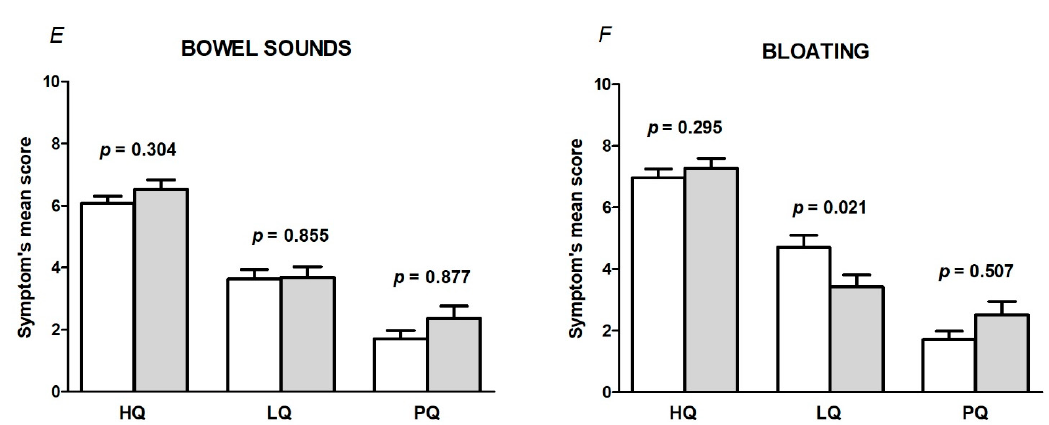
Figure 2. Global symptom score (GSS) ( A ) and diarrhea ( B ), abdominal pain ( C ), vomiting ( D ), bowel sounds ( E ), and bloating ( F ) mean scores in the studied population, subdivided according to lactose hydrogen breath test results. Lactose malabsorbers (HBT positive after lactose challenge), lactose absorbers (HBT negative after lactose challenge), respectively. HQ: home questionnaire; LQ: lactose questionnaire; PQ: placebo questionnaire. (6) The distribution of GSS at LQ, according to lactose HBT results expressed as delta increase of H2 or CH4 levels in the breath, is shown in Figure 3. Interest- ingly, there was no significant correlation between GSS and H2 or CH4 delta increase in the breath ( r = 0.204; p = 0.06).